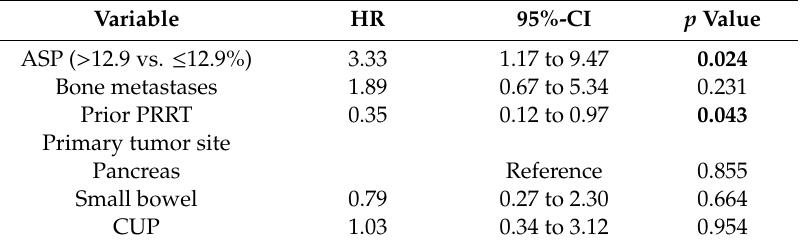
Table 3. Multivariable Cox regression for progression-free survival (PFS).